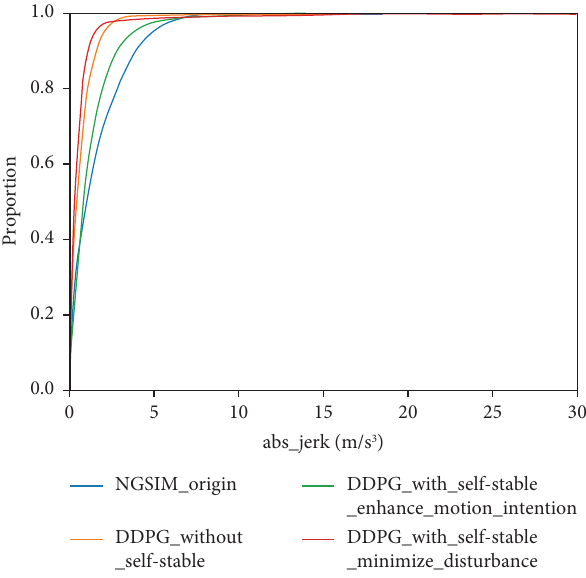
Figure 10: Cumulative distribution of jerk.